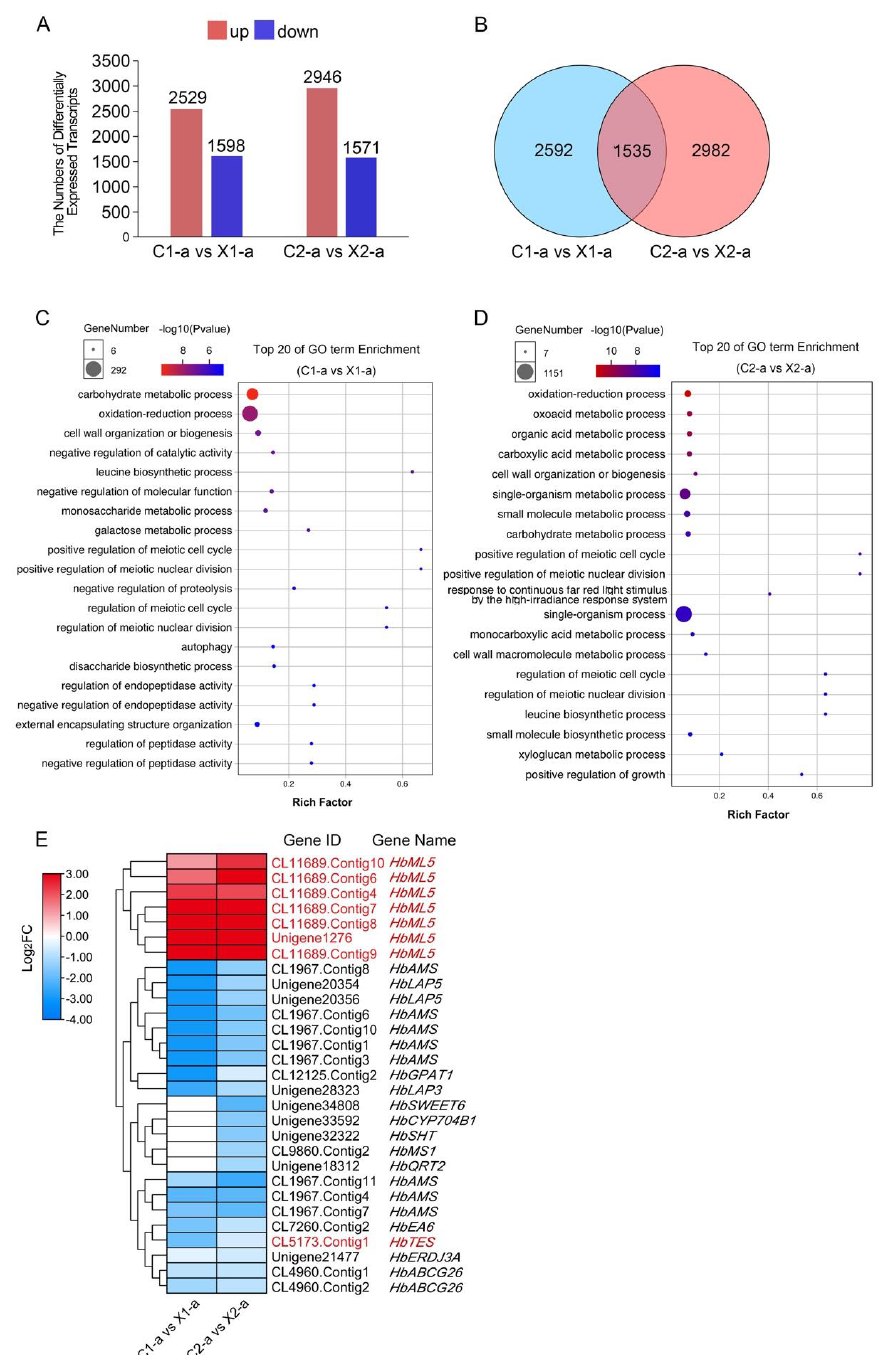
Figure 4. Analysis of the differentially expressed transcripts between male and female floral anthers. ( A , B ) Numbers of the differentially expressed transcripts in anthers transcriptome of male and female flowers. ( C , D ) GO functional enrichment of the differentially expressed transcripts in anthers’ transcriptome of male and female flowers; − log 10 Pvalue is depicted by color range from blue (low significance) to red (high significance), Rich factor refers to the ratio of the number of differentially expressed genes among the total number of genes in this term. The greater the Rich factor, the higher enrichment degree. ( E ) log2-transformed fold change (log2FC) values are depicted by color range from blue (down-regulated) to red (up-regulated). Slashes represent pairwise comparisons between two samples. Bar plots show the